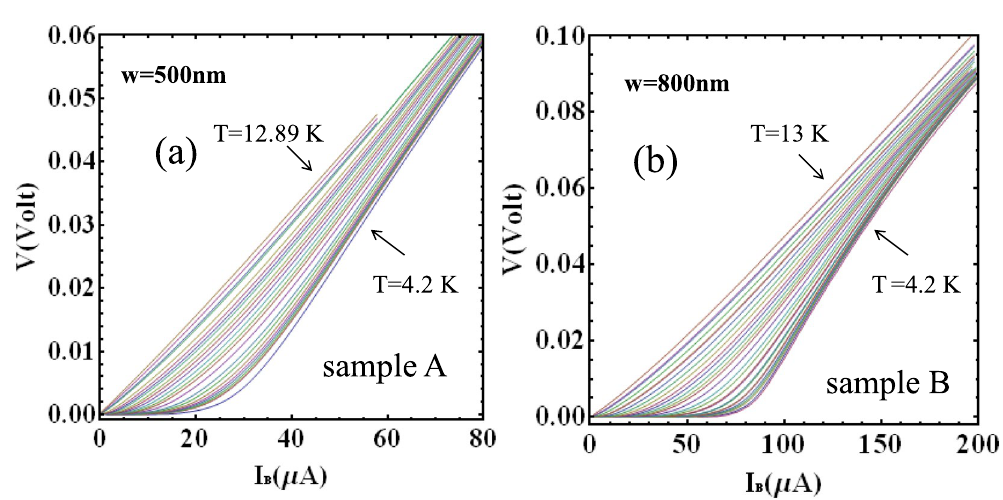
Figure 2. Current voltage characteristics: ( a ) Sample A, w = 500 nm. ( b ) Sample B, w = 800 nm for different temperatures between 4.2 K and 13 K. Sample A: ( T (K) = 4.2, 4.88, 4.97, 5.1, 5.29, 5.45, 5.72, 6.11, 6.38,